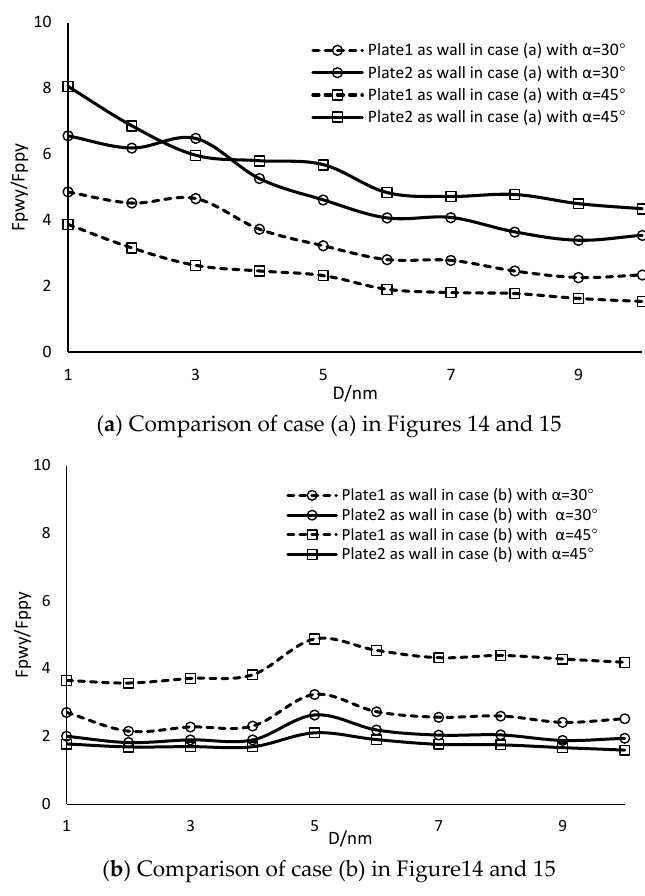
( b ) Comparison of case (b) in Figure14 and 15 Figure 16. Comparison of the calculated forces of different choices for the cases of edge-face type. Figure 16. Comparison of the calculated forces of di ff erent choices for the cases of edge-face